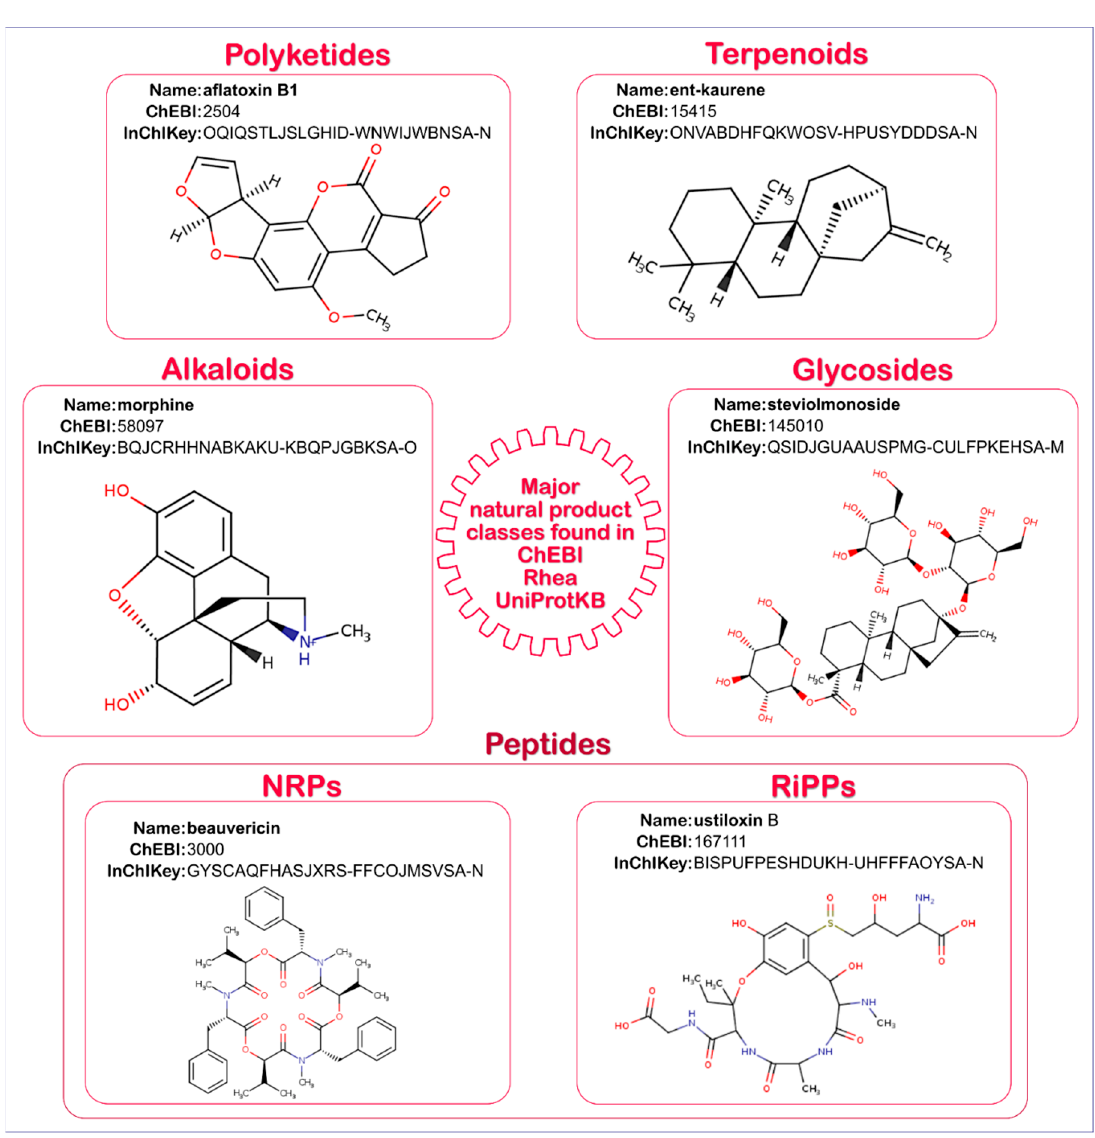
Figure 1. The major classes of natural products and representatives found in Chemical Entities of Biological Interest (ChEBI), Rhea, and UniProtKB. Examples used are ent-kaurene for terpenoids, morphine for alkaloids, steviolmonoside for glycosides, aflatoxin B1 for polyketides, beauvericin for non-ribosomal peptides (NRPs), and ustoloxin B for ribosomally synthesized and post-translationally modified peptides (RiPPs) starting with the precursor ribosomally synthesized cyclic peptide ustiloxin B precursor ustA (UniProtKB: